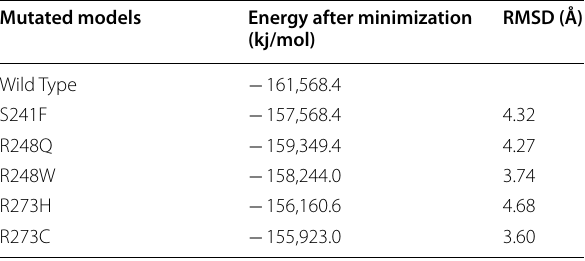
Table 8 RMSD (Å) values and total free energy after energy minimization of both wild-type and mutated protein models Mutated models Energy after minimization (kj/mol)